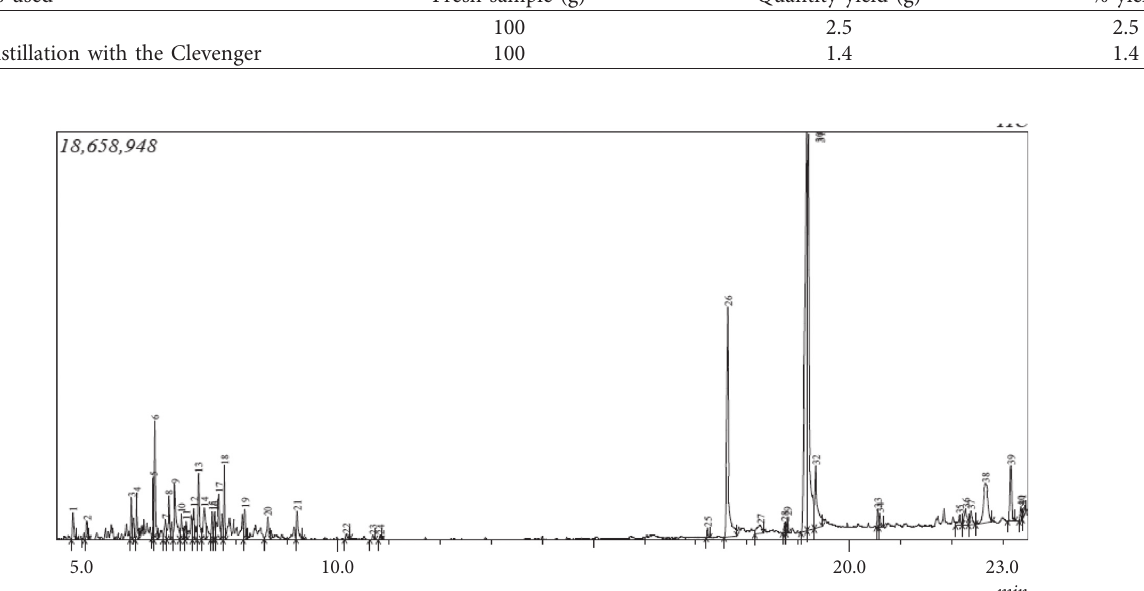
Figure 1: Chromatogram of essential oils of tamarind seed extracted with the Clevenger apparatus.